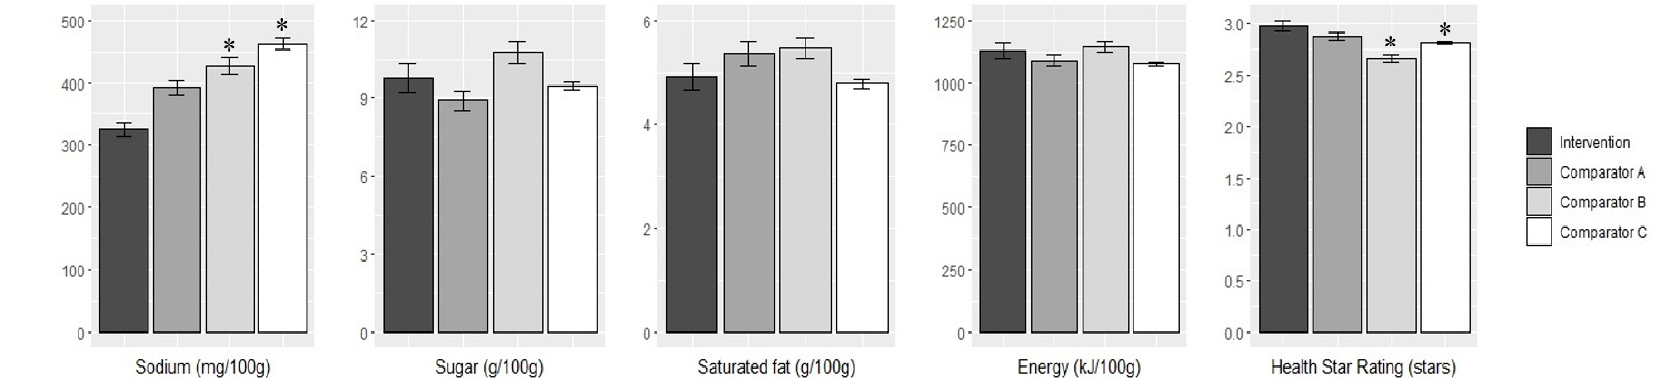
Figure 4. Comparison of the mean nutrient content (sodium (mg/100 g), sugar (g/100 g), saturated fat (g/100 g) and energy (kJ/100 g)) and Health Star Rating (stars) in 2018 between the intervention supermarket and comparators. Errors bars indicate the standard error (SE). Differences across groups were estimated using 1-factor ANOVA tests with Tukey’s honest significance difference test post-hoc analyses. * indicates significance difference compared to intervention supermarket ( p < 0.05).